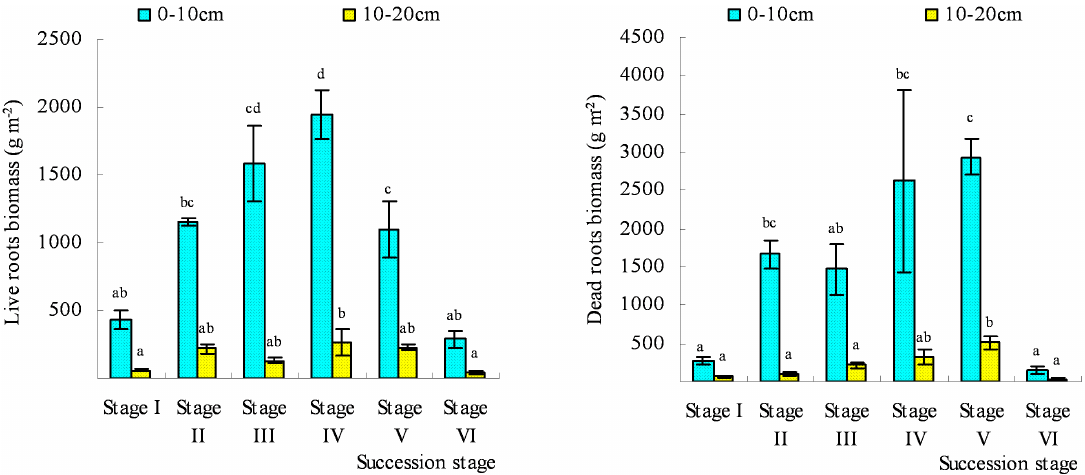
Figure 4. Living-root biomass (left) and dead-root biomass (right) at 0–10 and 10–20cm depths. The values represent the means ± 1SD of four replicates. Different letters in the figures indicate significant differences between the stages at P <0.05. The stage details refer to Fig.